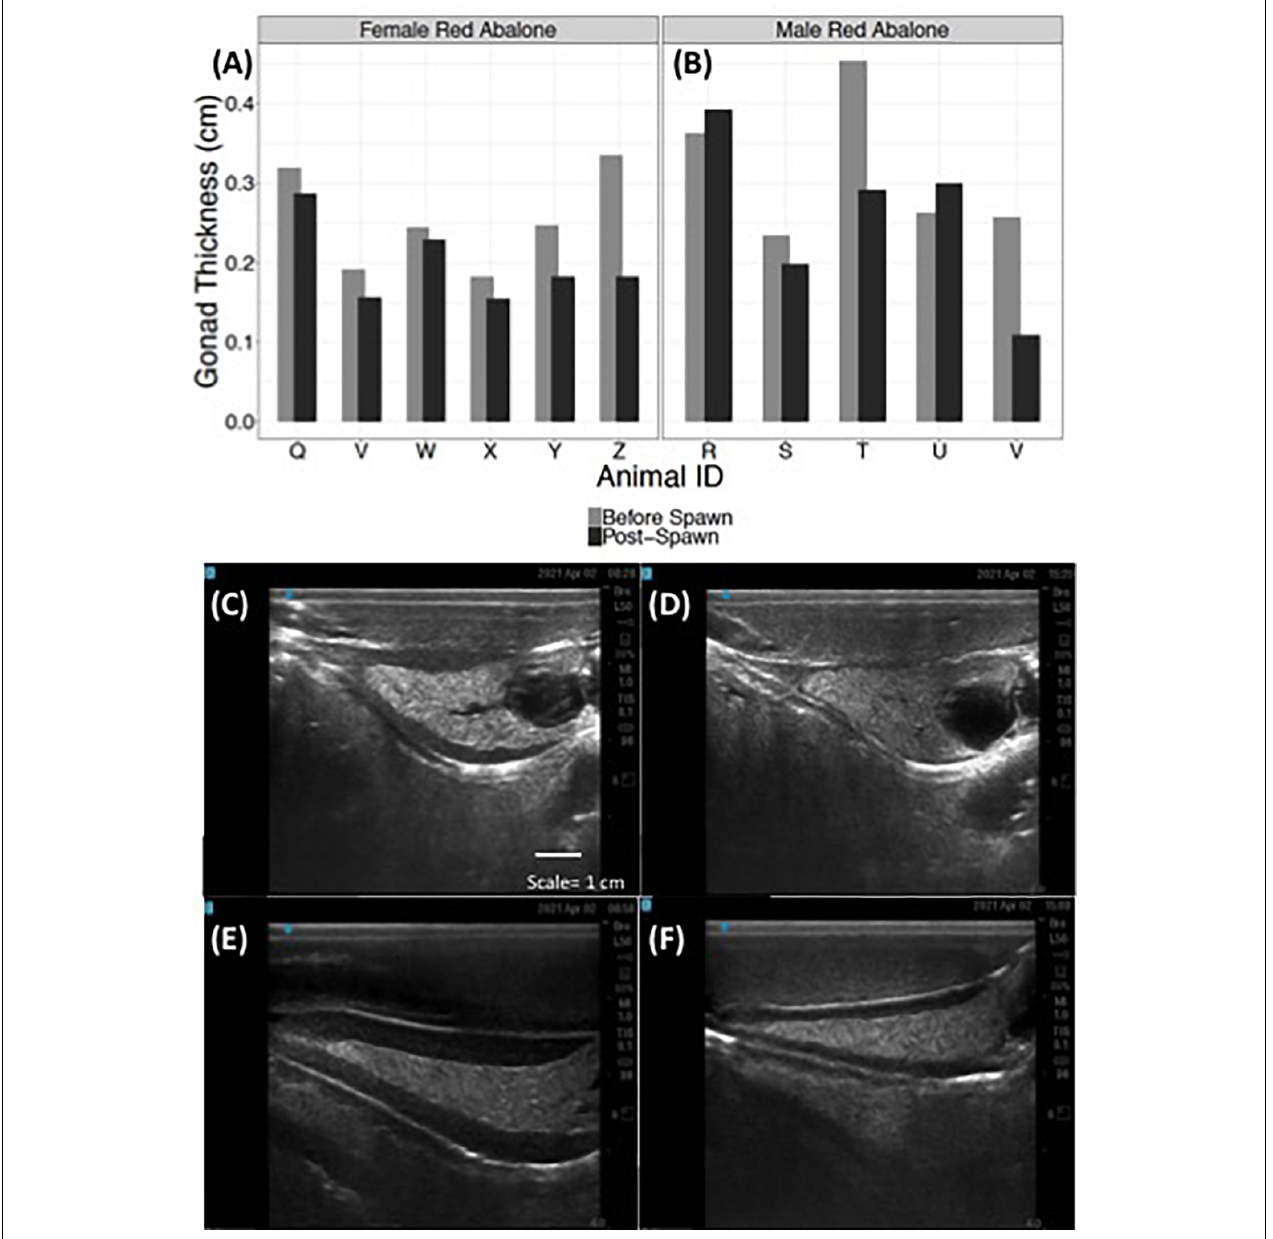
FIGURE 6 | Ultrasonography detects changes in red abalone ( Haliotis rufescens ) gonad thickness before and post-spawning. Quantitative changes in gonad thickness in female ( n = 6) (A) and male ( n = 5) (B) abalone before (light gray bars) and after spawning (black bars). Ultrasound images of a female abalone before (C) and after spawning (D) and of a male abalone before (E) and after spawning (F)